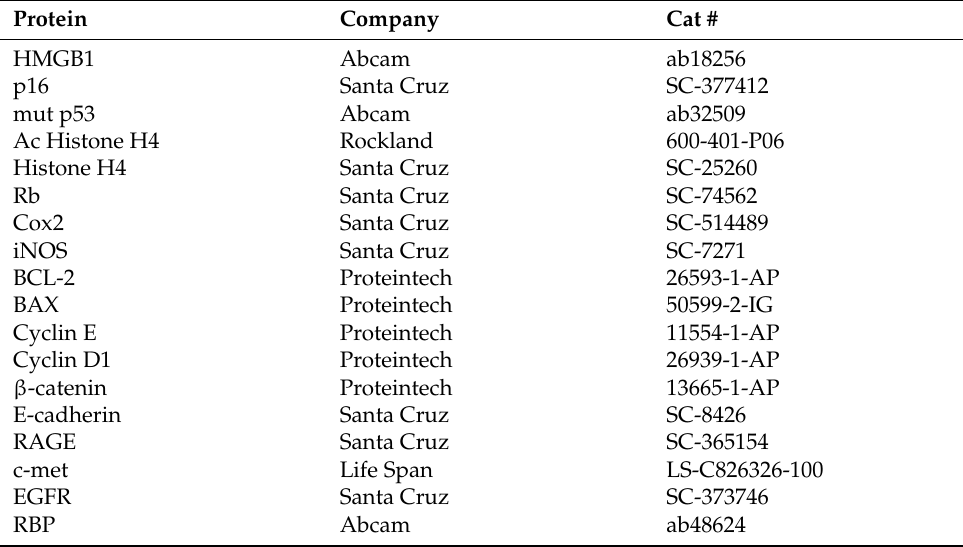
Table 3. List of antibodies used for the antibody